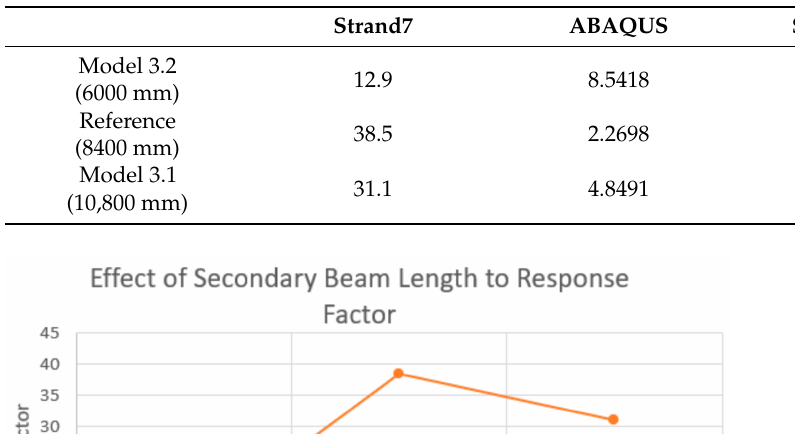
Table 12. Comparison of Response Factor between Different Secondary Beam Lengths.